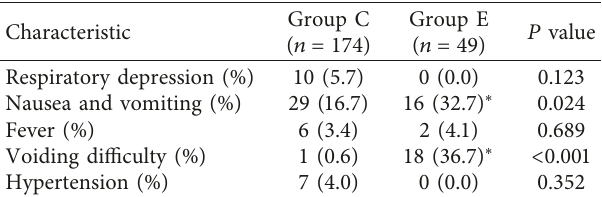
Table 3: Incidence of adverse